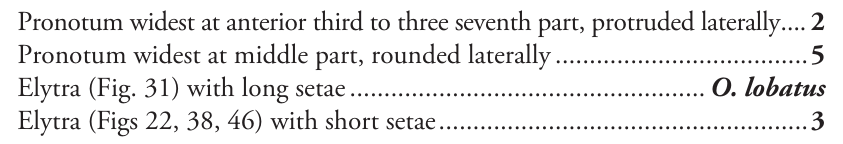
Diagnosis. Body (Fig. 26) with distinct pronoto-elytral angle. Head (Fig. 27) with a transverse groove separating clypeus and frons, the latter on each side with an interocu- lar pit-like depression and a short longitudinal depression or groove on postero-medial part. Anterior margin of labrum truncate, sometimes with a small medial emargina- tion. Pronotum (Figs 21, 30, 37, 45) with a narrow hyaline membranous cuticula, middle pronotal portion raised, and with longitudinal or transversal groove. Elytra (Figs 22, 31, 38, 46) with rows of punctures (Chiesa 1959; Hansen 1987; Jäch